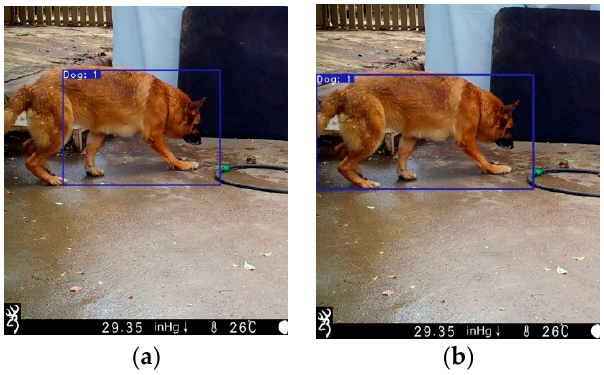
Figure 6. Dog tracking with DeepSORT and DeepDogTrack models. ( a ) DeepSORT model; ( b ) DeepDogTrack model.